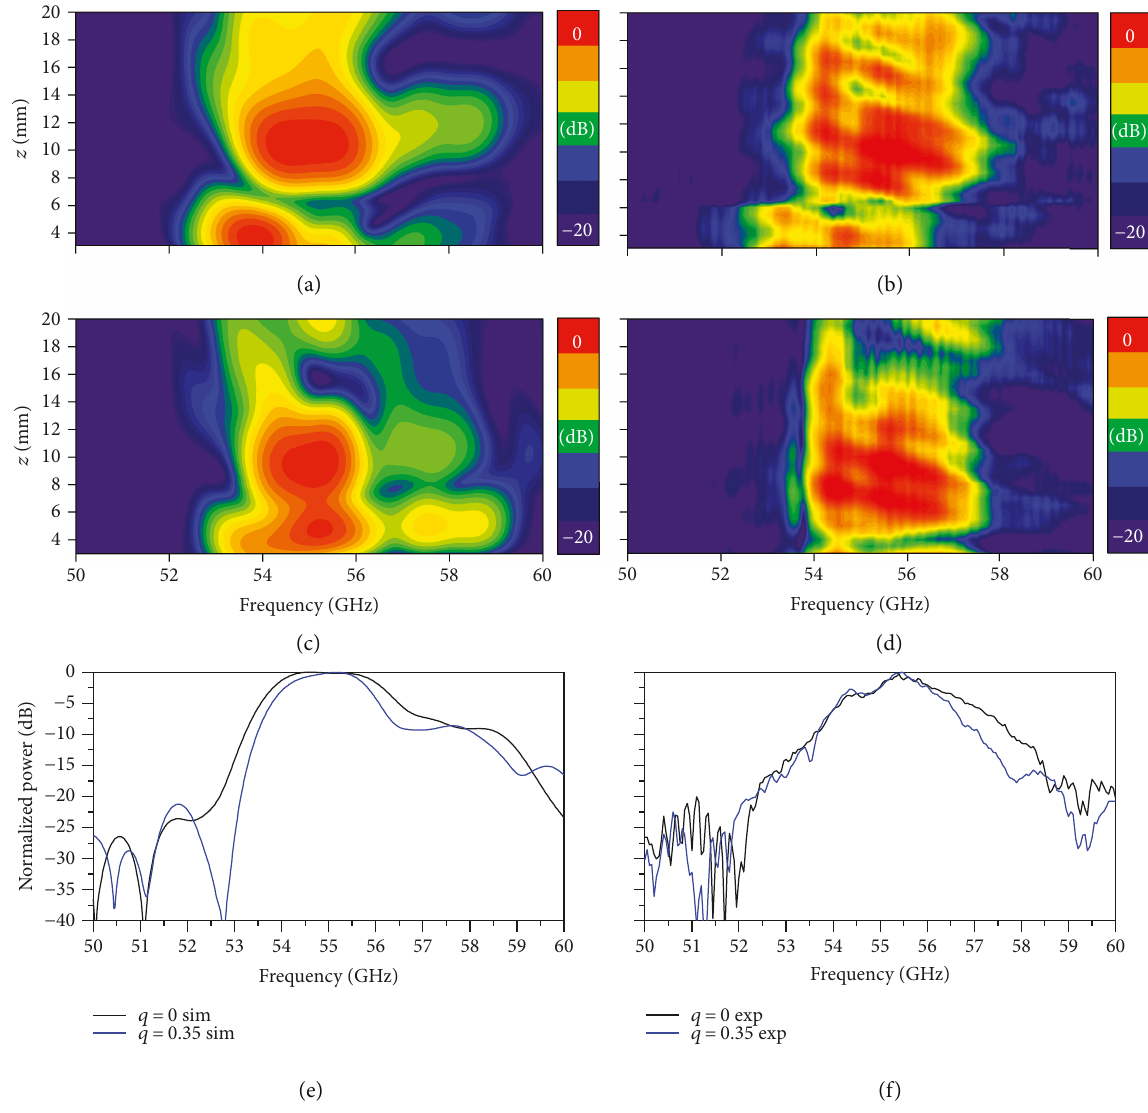
Figure 3: Spectral response. Numerical (a, c) and experimental results (b, d) of the power distribution spectra along the propagation z -axis for the phase reversal designs with q = 0 (a, b) and q = 0 35 (c, d). The simulation and experimental results of the spectral response of power distribution at each FL are shown in (e) and (f),